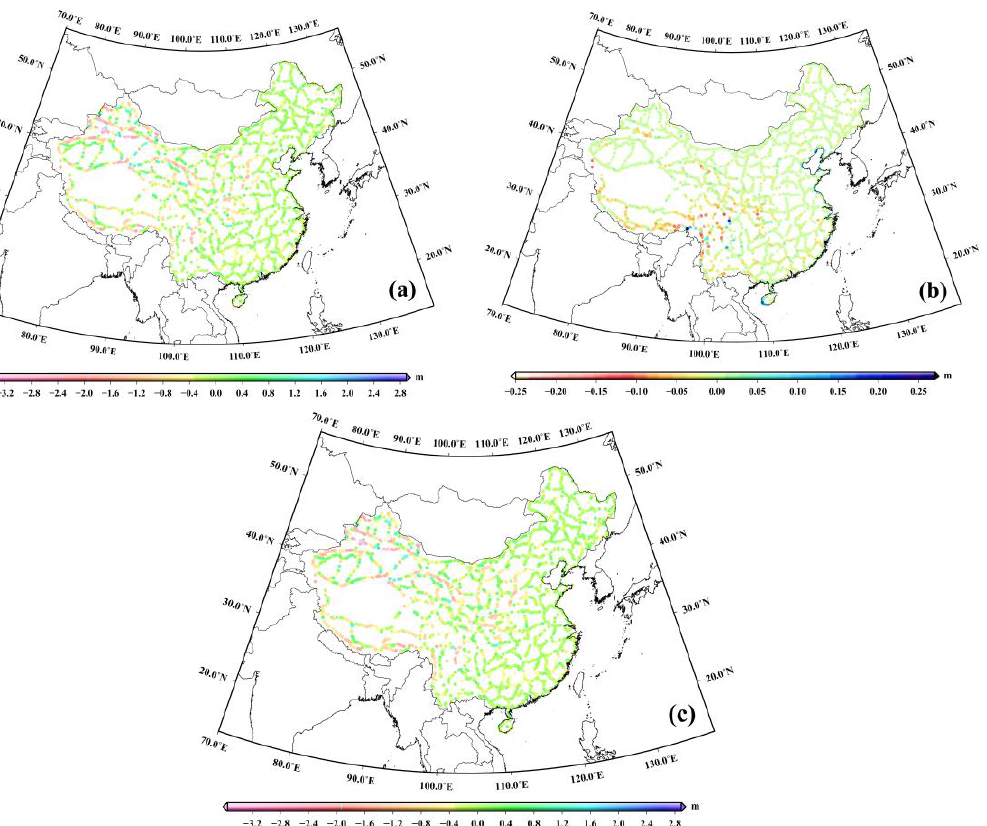
Figure 7. ( a ) Omission errors of satellite-only GFMs represented by ζ EGM 2008 , ( b ) omission errors for satellite-only GFMs represented by ζ RTM , ( c ) total omission errors of satellite-only GFMs.